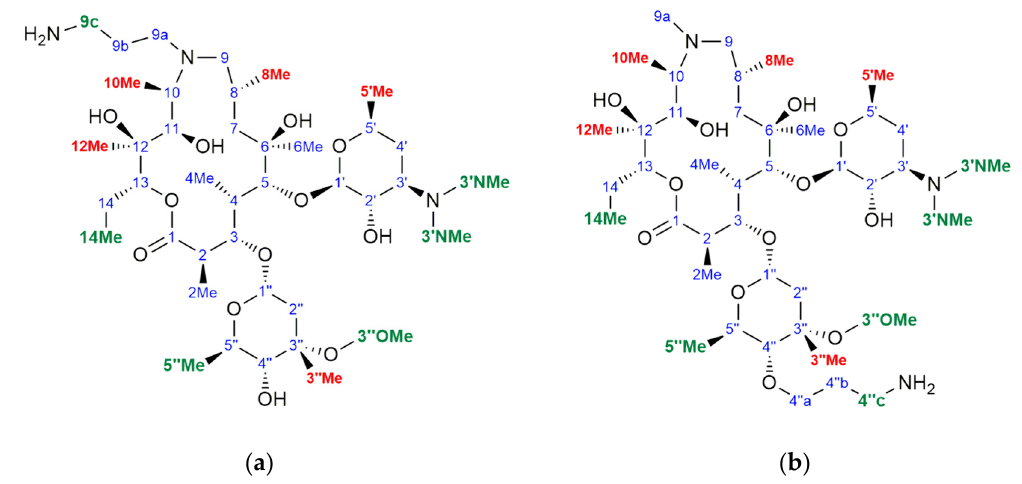
Figure 6. Chemical structure, atom numbering and binding epitopes (green and red) of ( a ) 1a and ( b ) 1c.